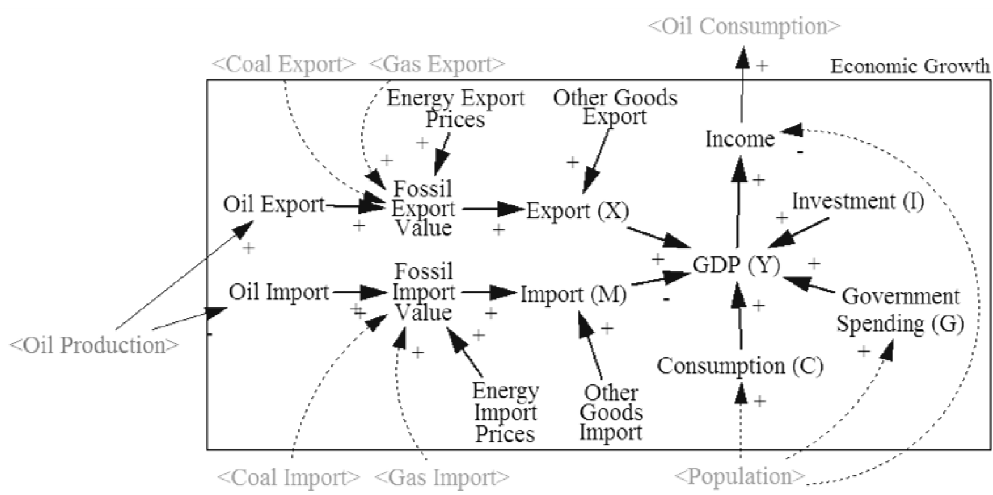
Figure 5. Economic growth